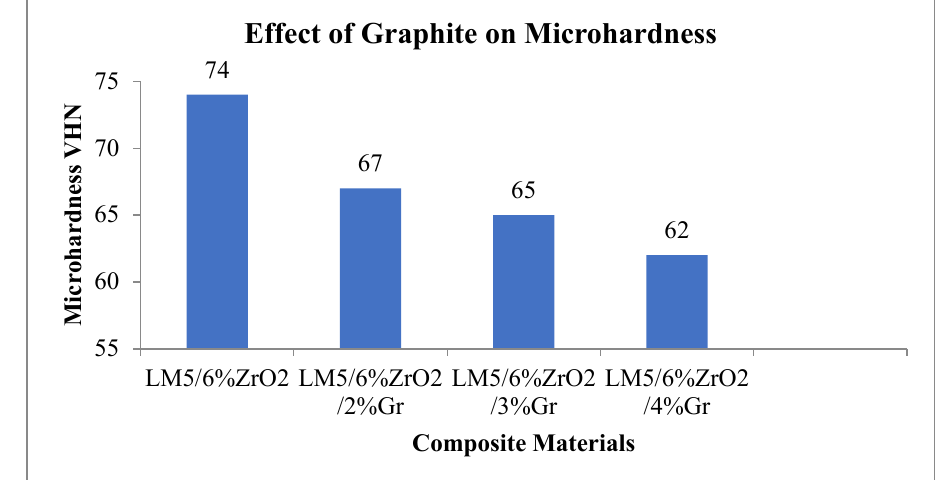
Figure 10. Effect of graphite on the microhardness of composites.